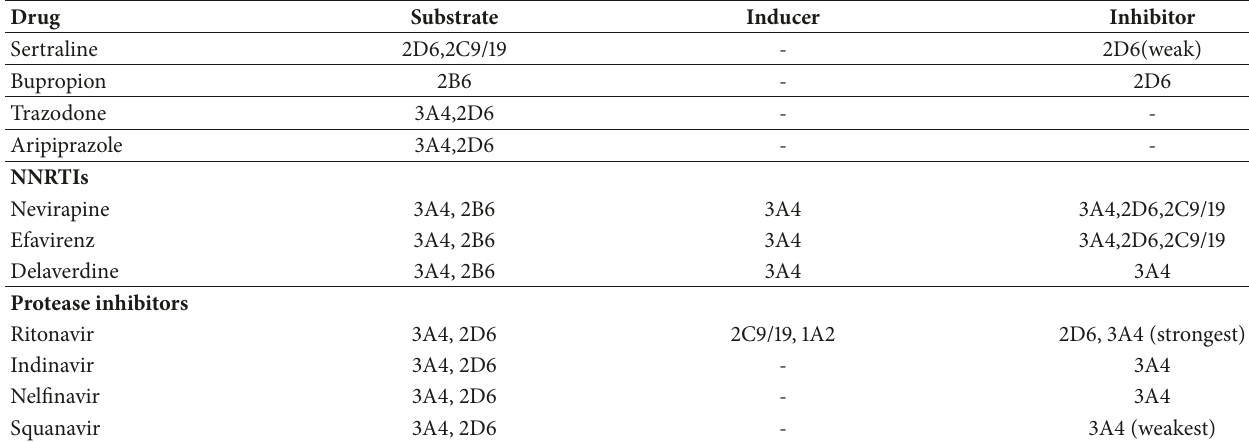
Table 1: List of drugs metabolized by cytochrome P450